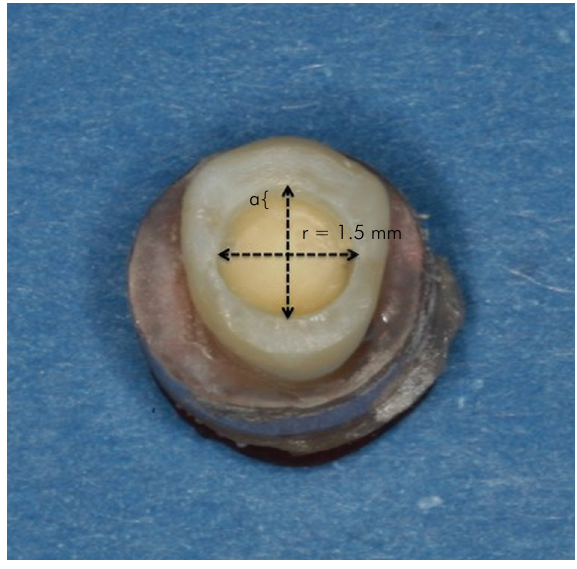
Figure 1. A representative view of cavity dimensions of round shaped Class I cavity: a = 1.5 mm occlusal dept, r = radius of the cavity.